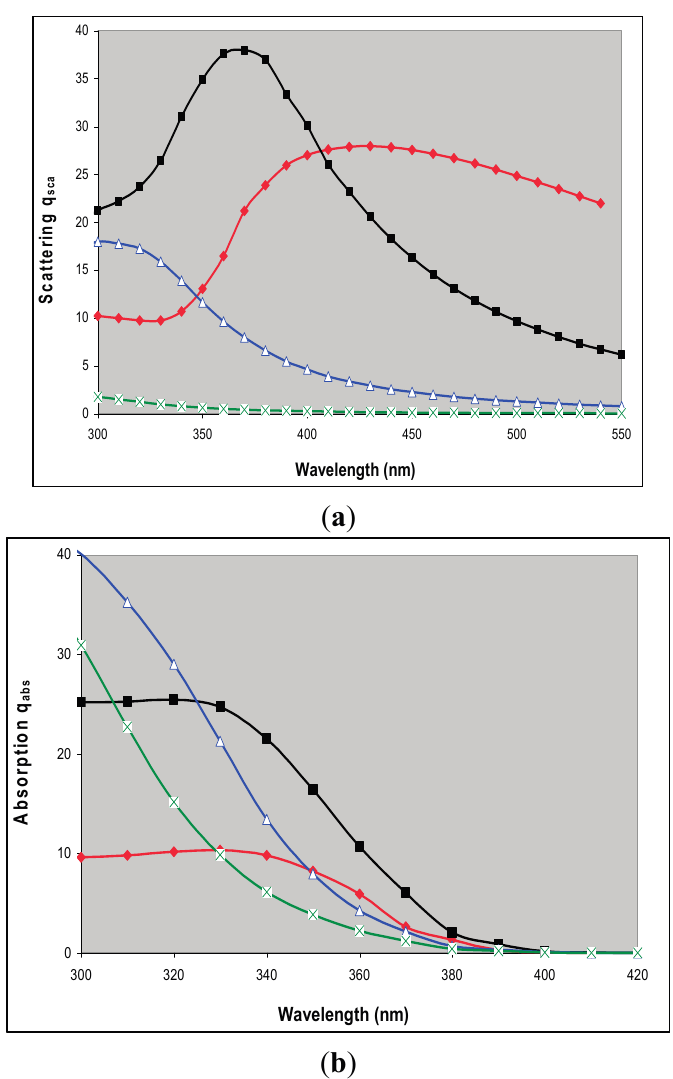
Figure 3. Mie theory calculations of ( a ) q sca , scattering and ( b ) q abs , absorption per